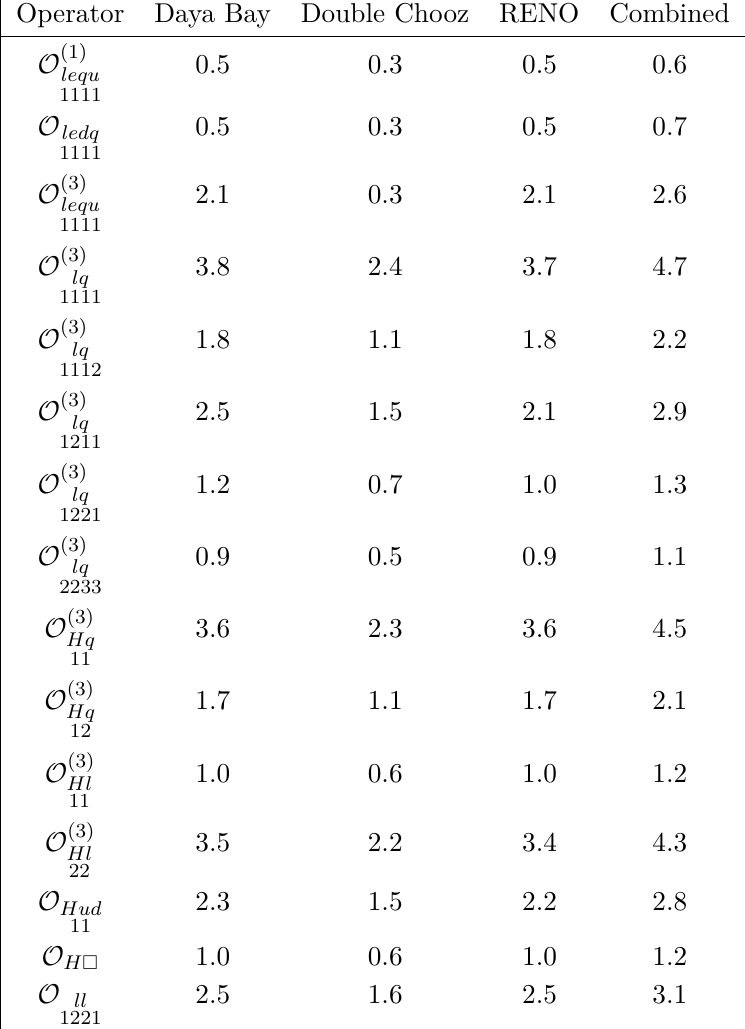
Table 7 . Lower bounds on the UV scale Λ as obtained from the reactor neutrino experiment data. The constraints are provided in units of TeV at 95% CL significance for Daya Bay, Double Chooz and RENO, both individually and